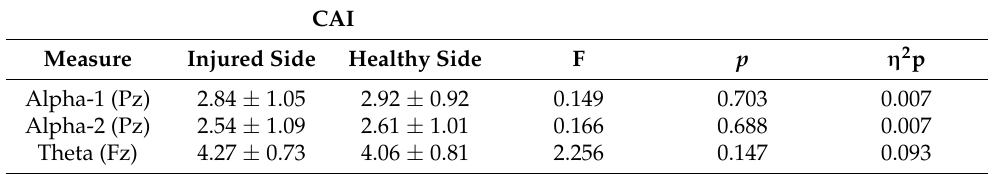
Table 3. EEG results between two limbs in CAI